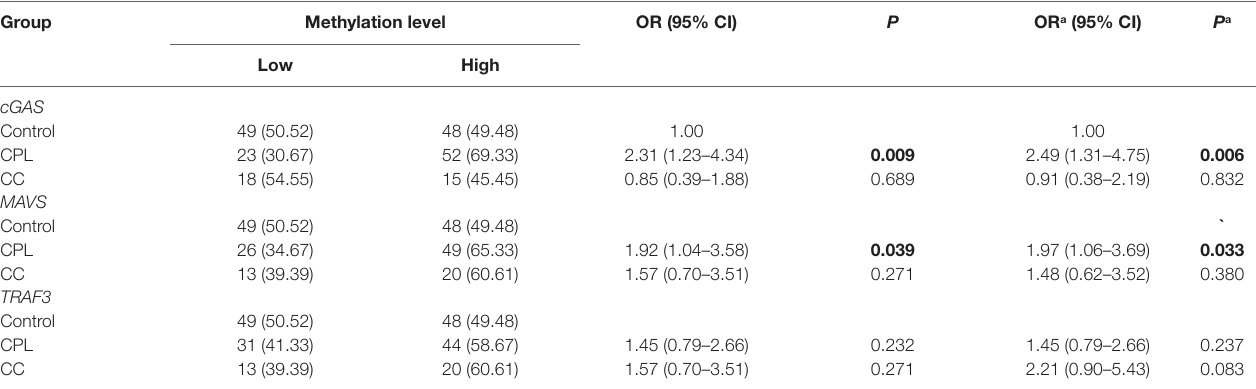
TABLe 3 | Association analysis of the promoter methylation level of cyclic GMP-AMP synthase ( cGAS) /mitochondrial antiviral-signaling ( MAVS) /tumor necrosis factor receptor-associated factor 3 ( TRAF3) gene with the risk on cervical precancerous lesion (CPL), and cervical cancer (CC). Group